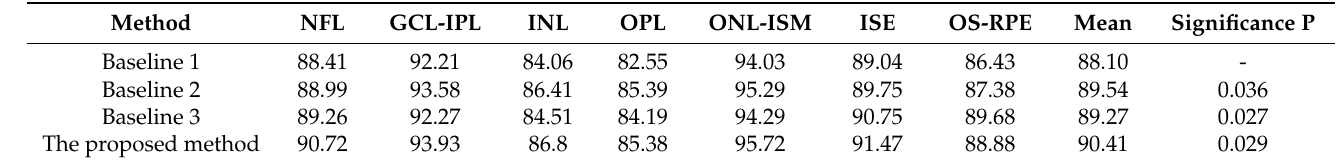
Table 5. Quantitative comparison between Baseline 1-3 and the proposed method using Dice coeffi- cient scores.